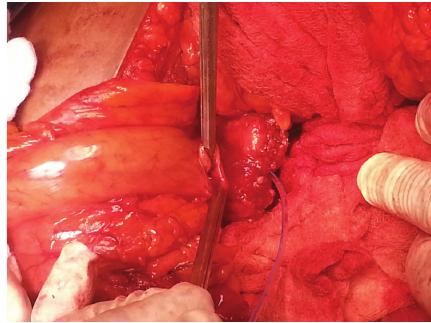
Figure 1: Pancreatic duct opposing the transverse full thickness opening in the posterior gastric wall.